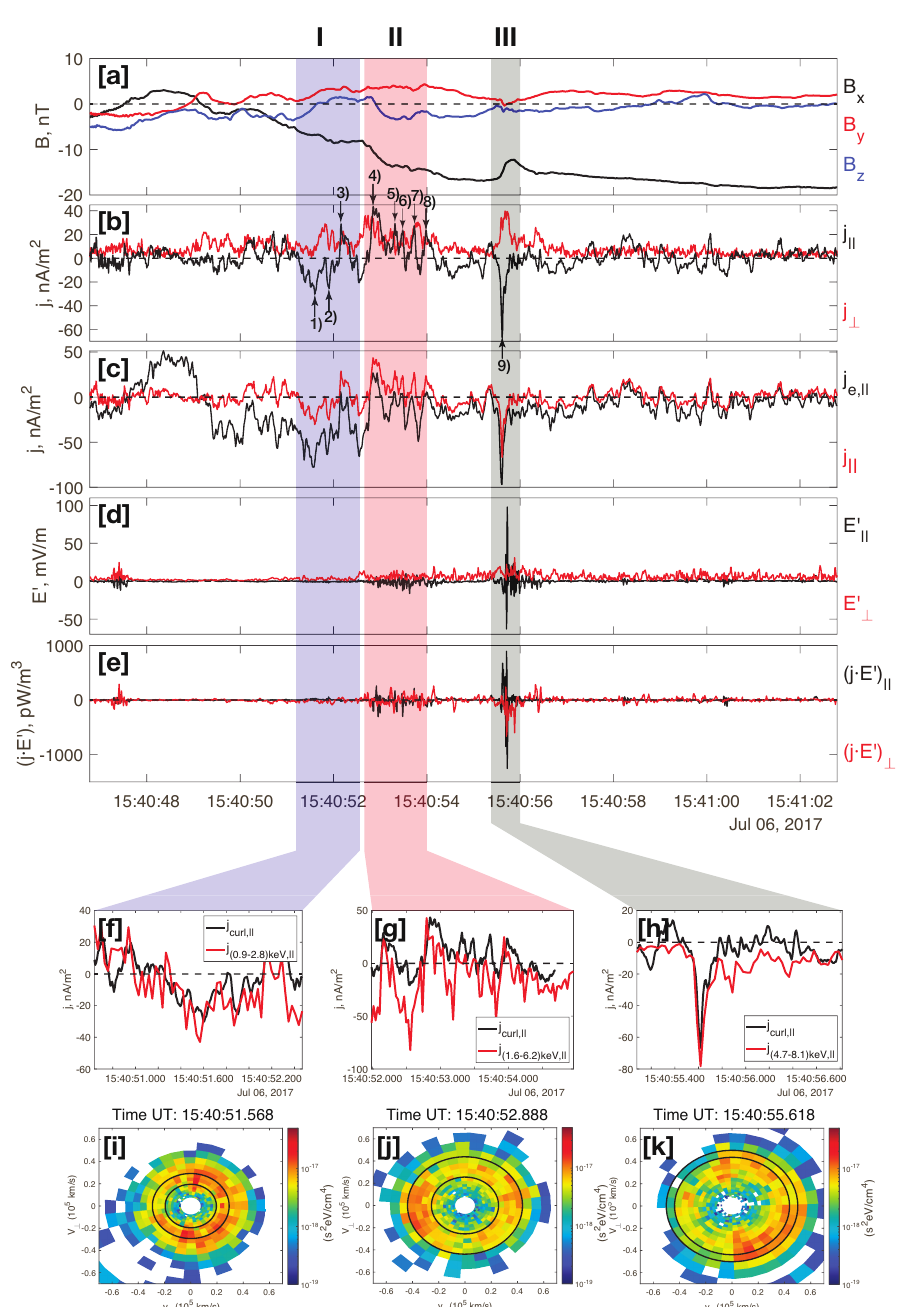
Figure 2. From top to bottom: ( a ) Three components of the magnetic field; ( b ) the parallel and per- pendicular components of electric current density calculated using the curlometer technique; ( c ) the parallel component of the electric current density calculated at the MMS barycenter using electron moments from the FPI experiment onboard four MMS probes ( j || , e ) and the parallel current density calculated by using the curlometer technique ( j || ); ( d ) the parallel and perpendicular components of the nonideal electric field, E’; ( e ) the parallel and perpendicular components of energy dissipation. Three intervals of FACs are shaded by blue, pink and grey colors and are marked as “I”,”II” and “III”, respectively. Panels ( f – h ) present a comparison of j || and j || , e calculated by using electron moments deduced from 3D electron velocity distribution function in the selected energy range. The energy range used for the current density calculation in each FAC interval is presented in the legend of each panel. Panels ( i – k ) show 2D cuts of electron velocity distribution functions in the ( V || , V ⊥ ,1 )